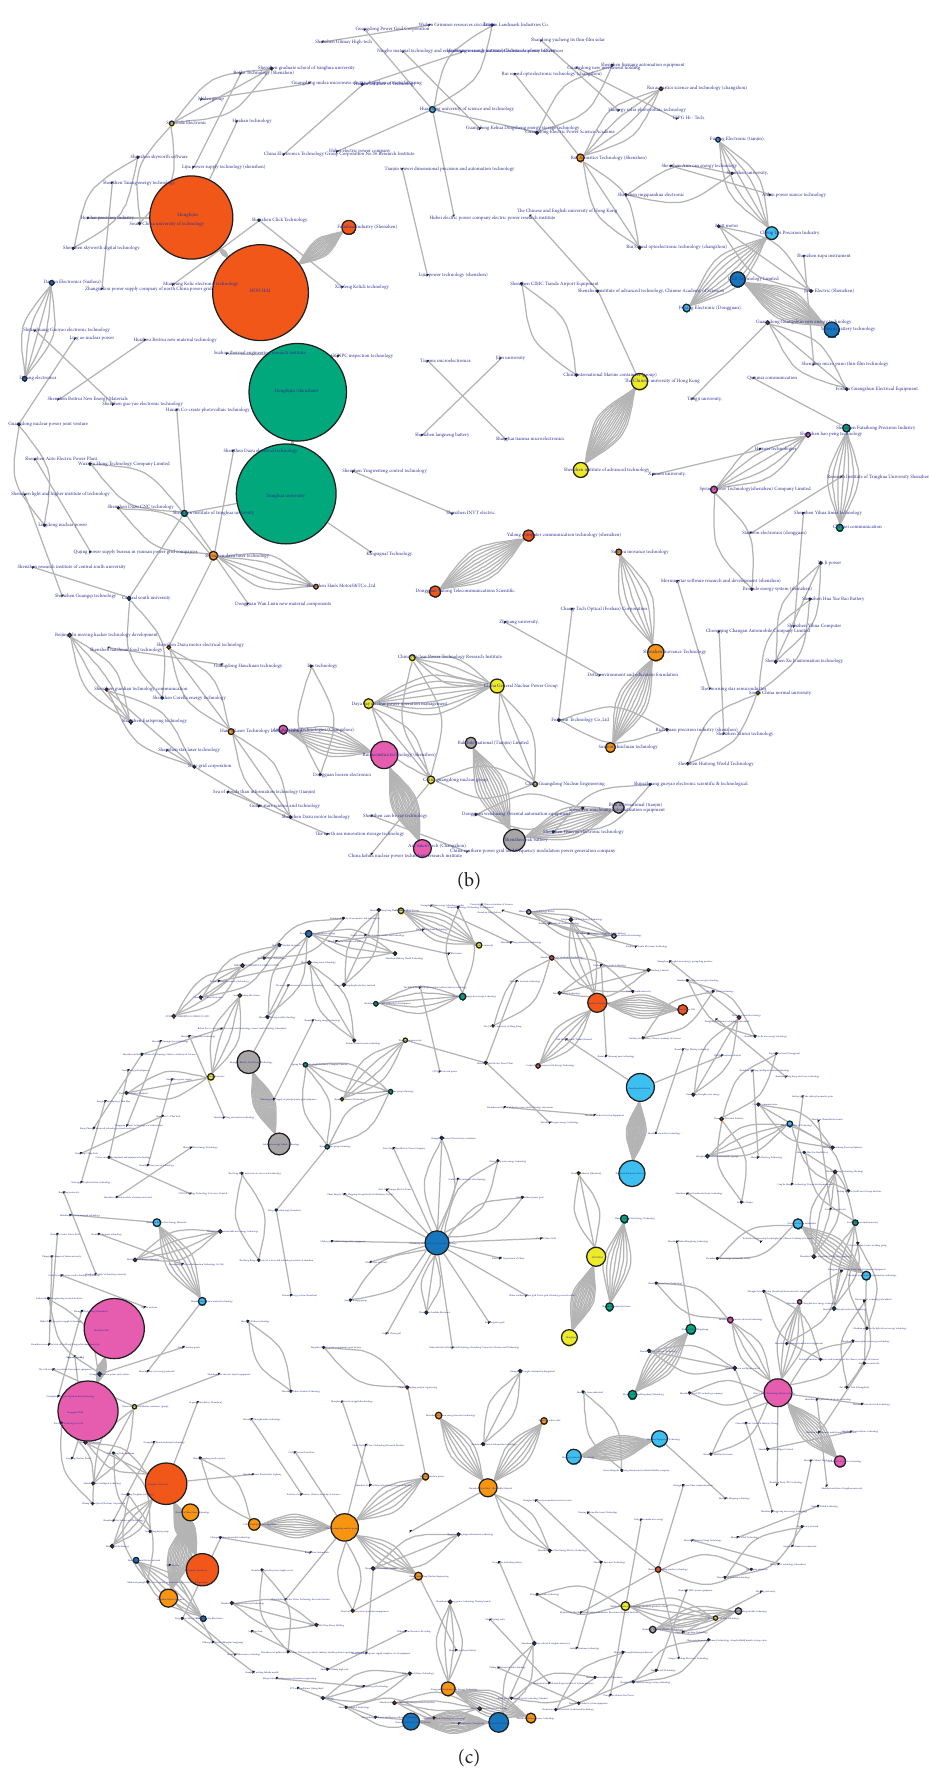
Figure 1: Topological evolution of NEVs coinvention network. (a) 2006–2009, (b) 2010–2013, (c)